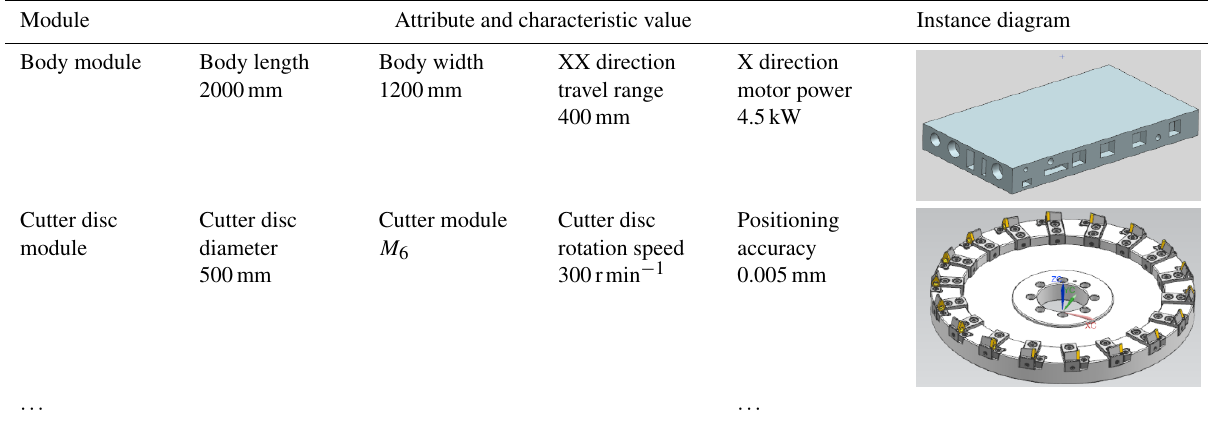
Table 10. Configuration result of the main modules of the special machine tool for VH-CATT cylindrical gears. Module Body